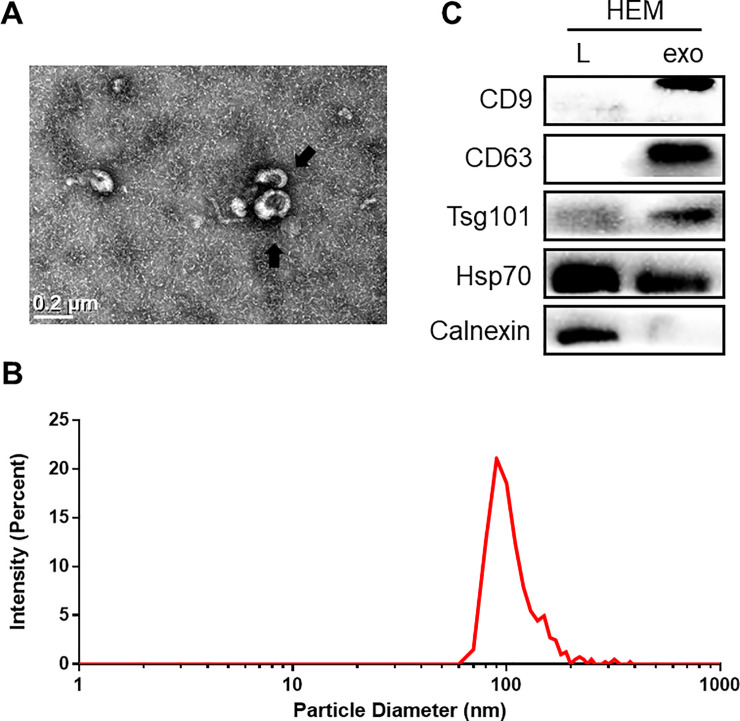
Characterization of primary melanocyte-derived exosomes.(A) The collected products had a cup shape as evidenced by using a transmission electron microscope. The arrow indicates exosomes, and the scale bar represents 0.2 μm. (B) Size distribution of microvesicles (nm) assessed by nanoparticle tracking analysis. (C) Confirmation of exosome specific markers such as CD9, CD63, TSG101. Exosomal negative maker Calnexin was lost in the samples.